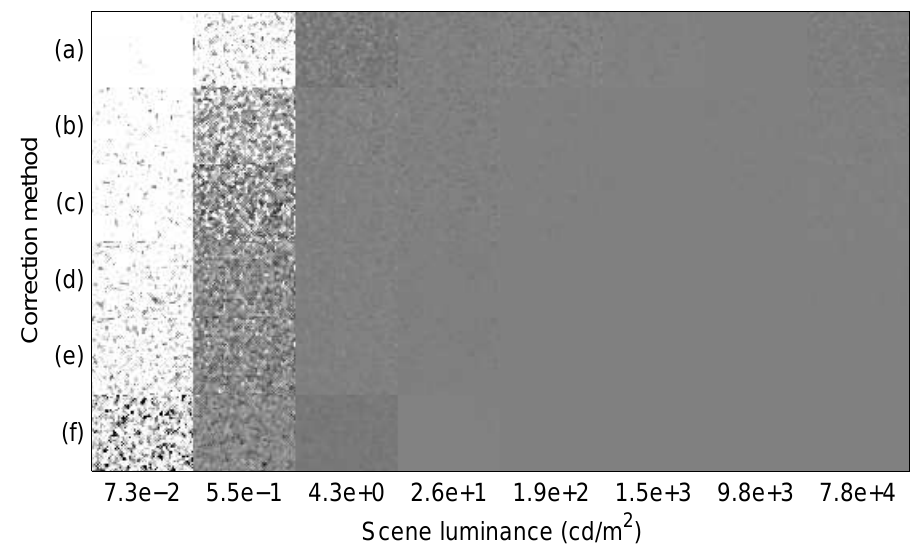
Figure 7. Corrected images versus correction method. Top to bottom: ( a ) the PR( 1 ) method ( 2 ppp ); ( b ) the IPR( 2 ) method ( 24 bpp ); ( c ) the IPR( 2 ) method ( 3 ppp ); ( d ) the IPR( 3 ) method ( 40 bpp ); ( e ) the IPR( 3 ) method ( 4 ppp ); and ( f ) the OGB method ( 3 ppp ). With perfect FPN and photometric correction, all pixels would have a uniform grey